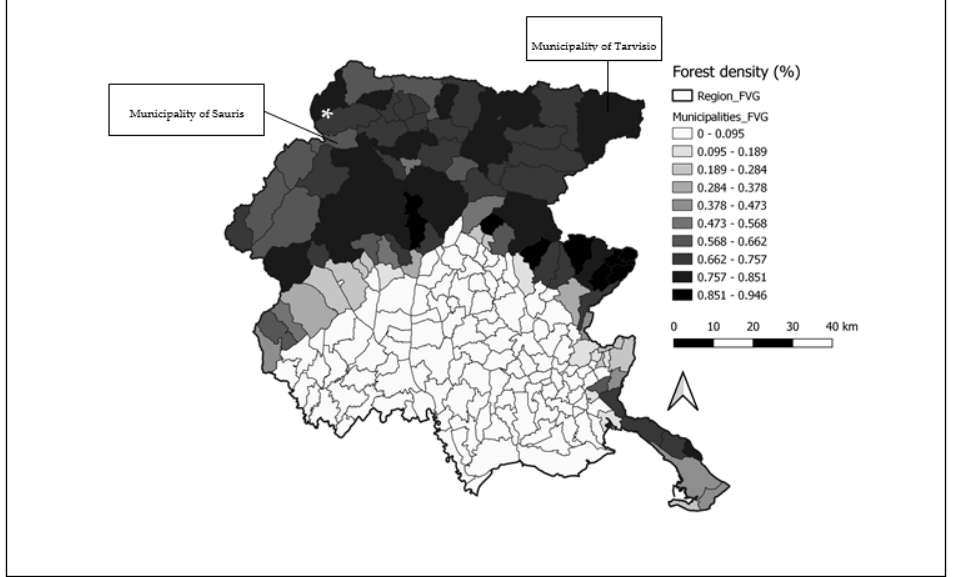
Figure 4. Source: SITFOR FVG. Forest density: % of municipal territory covered by trees. Geographic distribution of forest categories. Regional Infrastructure of Environmental and Territorial Data (IRDAT). Friuli Venezia Giulia Region. * Municipality of Sappada: unavailable data estimated by interpolation. Elaboration: authors.